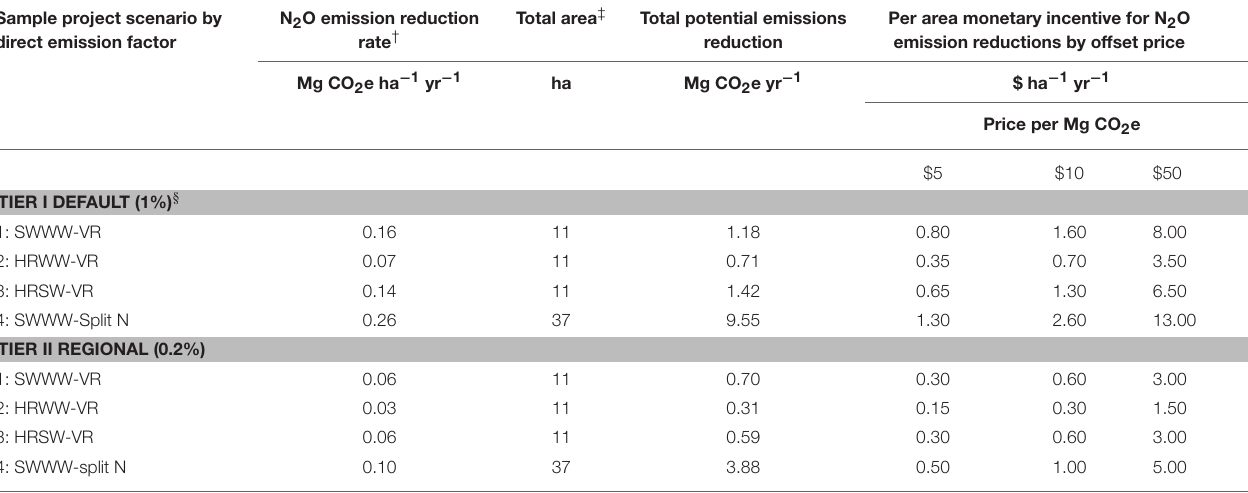
TABLE 7 | Nitrous oxide emission reduction potential and offset credit incentive for the agricultural N management sample projects † . Sample project scenario by direct emission